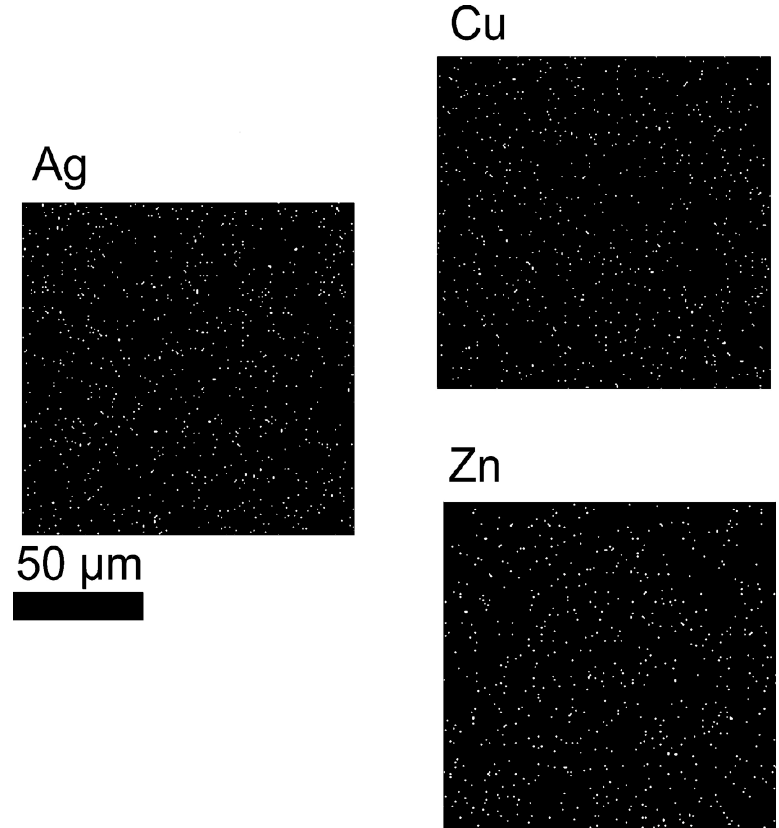
Figure 8. Energy-Dispersive Spectroscopy (EDS) maps of Ag, Cu and Zn in the bulk Ti23Zr25Nb-based composite with the 9 wt.% 45S5 Bioglass and 1 wt.% Ag, Cu, Zn.